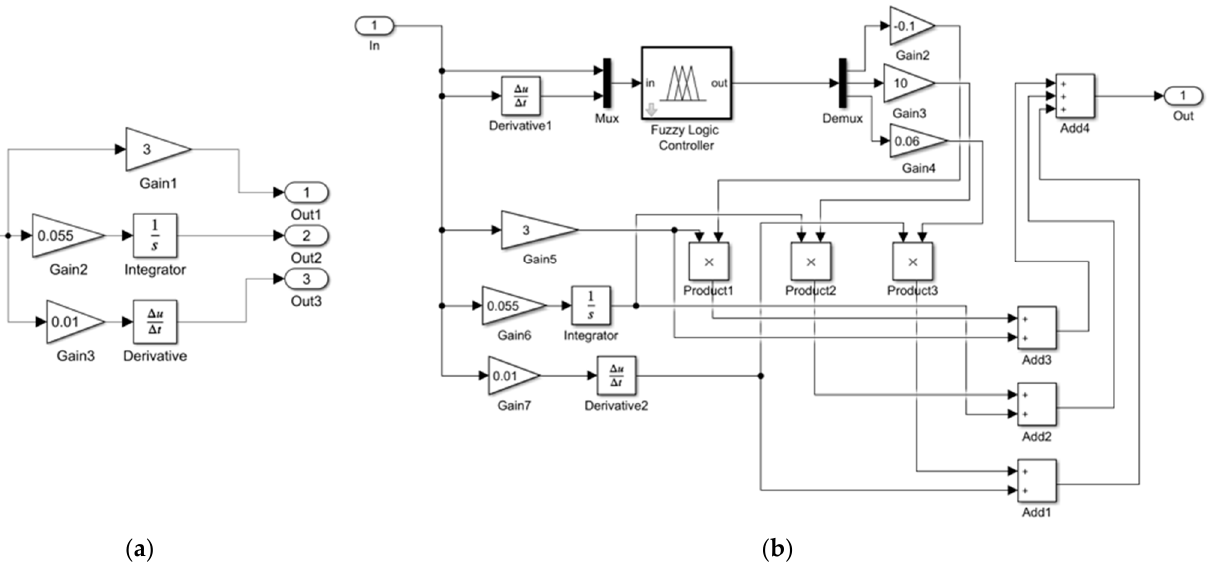
Figure 13. ( a ) Traditional PID simulation model; ( b ) fuzzy PID simulation model.